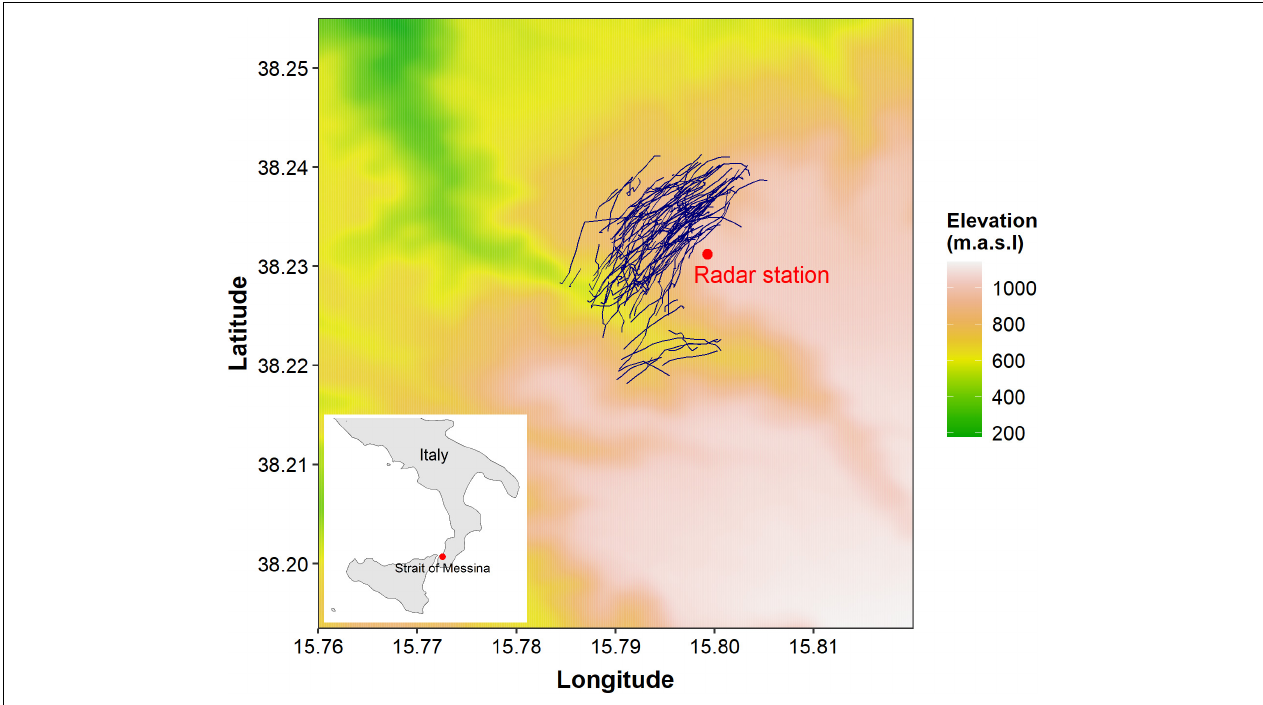
FIGURE 1 | Map of the study area showing the position of the radar and observers (red dot). Radar tracks of one day (20/04/2017) are depicted in dark blue. These tracks were recorded in a day without fog. Inset figure shows the study location in Southern Italy, in close proximity with the Strait of